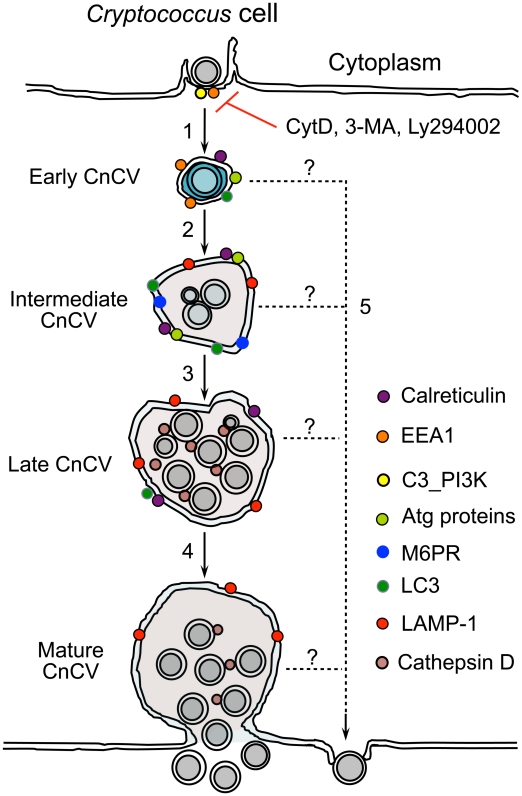
Proposed model depicting Cn subversion of Atg proteins for intracellular replication and dissemination.Host cell phagocytosis of Cn cells is class III PI3-kinase (C3_PI3K) and actin-dependent. This process is blocked by the PI3-kinase inhibitors 3-MA, LY294002 and the actin polymerization inhibitor cytochalasin D (CytD) (1). Internalized Cn resides in a Cn containing vacuole (CnCv). Early CnCvs interact with components of the endocytic pathway and sequentially obtain early endosome (EEA1), late endosome (M6PR) and lysosome (LAMP-1 and cathepsin D) markers (2). Infection by Cn may also activate the host cell autophagy pathway. Atg proteins such as Atg5, Atg9a and LC3 are recruited to the vicinity of CnCVs. Activated host cell Atg proteins promote the maturation of early CnCVs to form intermediate CnCVs (2). These compartments support Cn replication (3). Finally, late CnCVs may fuse with the plasma membrane, via an undefined mechanism, which results in the escape of replicative Cn cells from infected host cells (4). Extrusion in the absence of Cn replication and/or CnCv maturation may also occur (5).